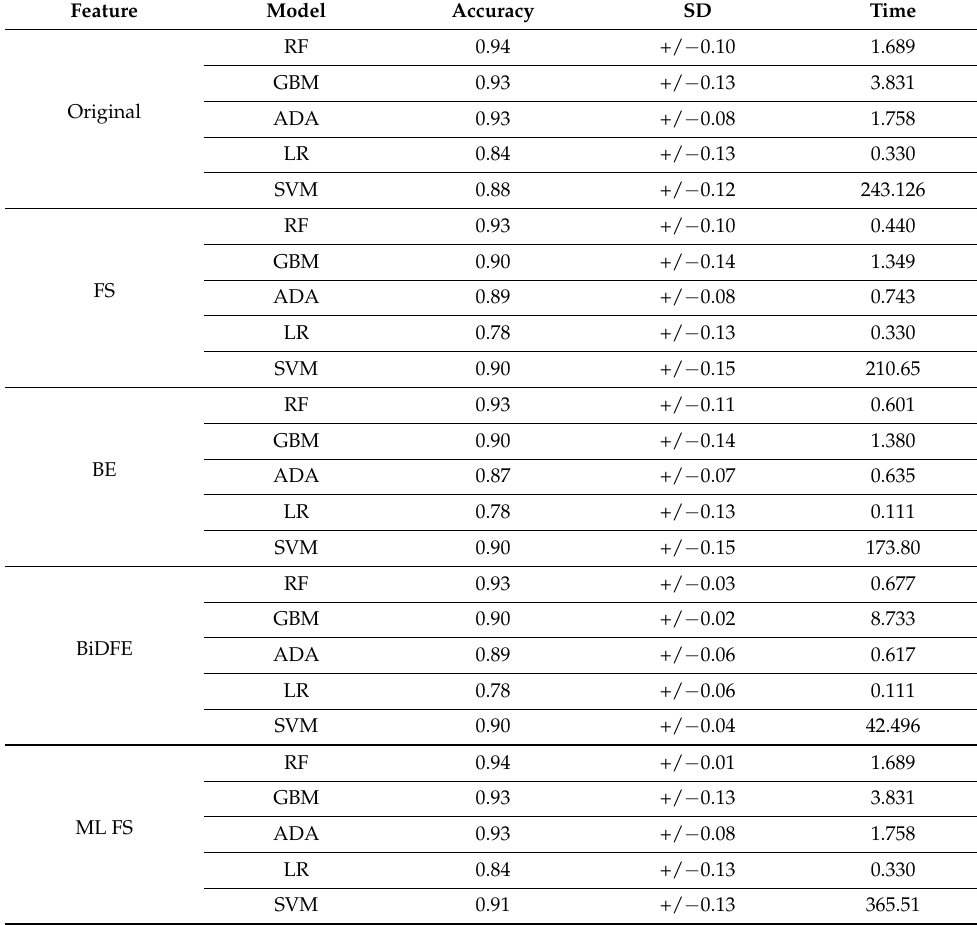
Table 14. Results of 10-fold cross-validation.